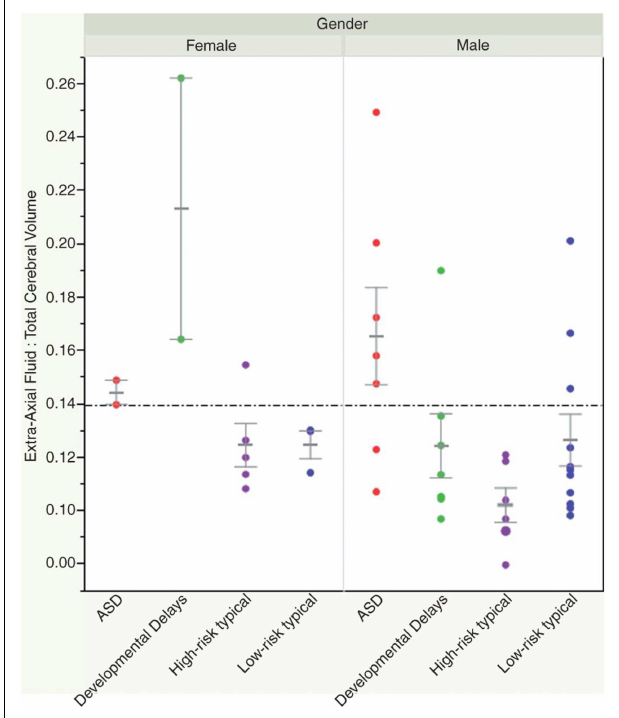
FIGURE 2 | Shen et al. (42) showed how an elevated ratio of fluid:brain volume (above 0.14) at 12–15months of age was predictive of a subsequent diagnosis ofASD, with 78% sensitivity and 79% specificity in their sample . Reproduced with permission from Shen et al. (42).